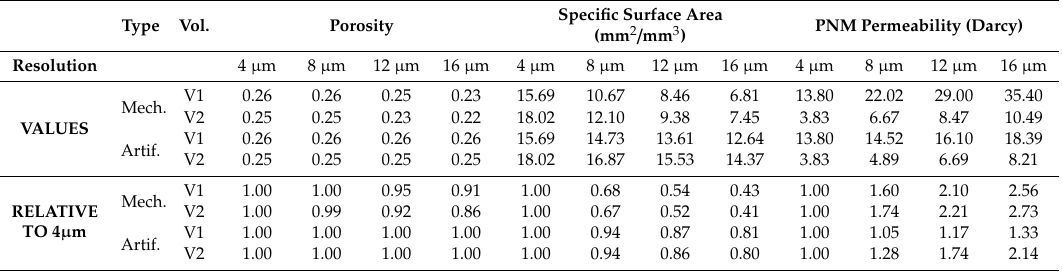
Table 4. Impact of resolution on porosity, specific surface area and absolute permeability determined from pore network models, studied for two volumes of 1000 3 voxels each. Relative di ff erence with expected highest resolution data is